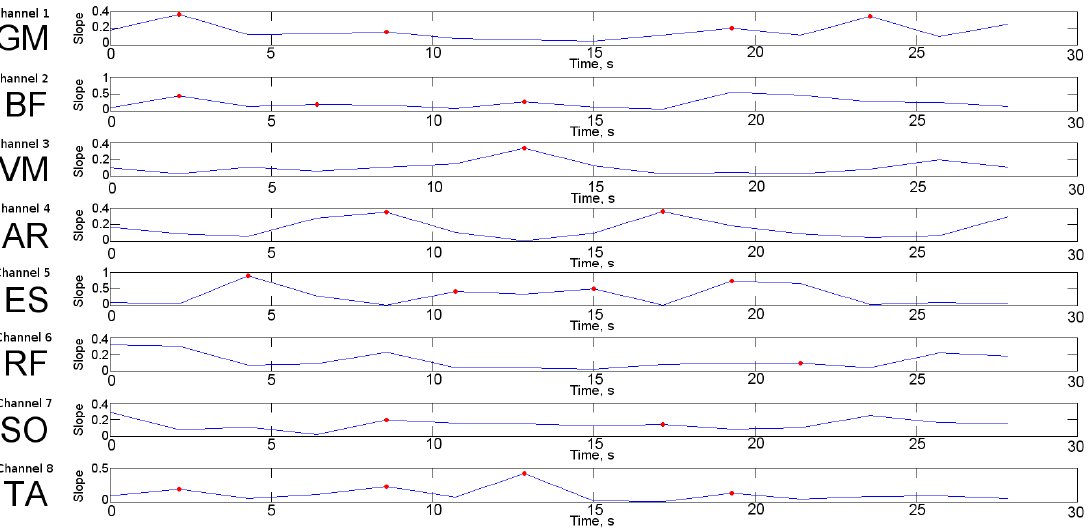
Figure 2. SC variation from EMG preprocessed and averaged signals from 8 measurements. Each channel represents the signal from the gastrocnemius medialis (GM), the biceps femoris (BF), the vastus medialis of the quadriceps (VM), the abdominal rectus (AR), the erector spinae (ES), the rectus femoris (RF), the soleus (SO), and the tibialis anterior (TA) muscles over a duration of 30 seconds. Slope indicates the spectrum shift (lower to higher or higher to lower frequencies) in each EMG channel. Red dots indicate the point where shifting to lower frequencies starts.